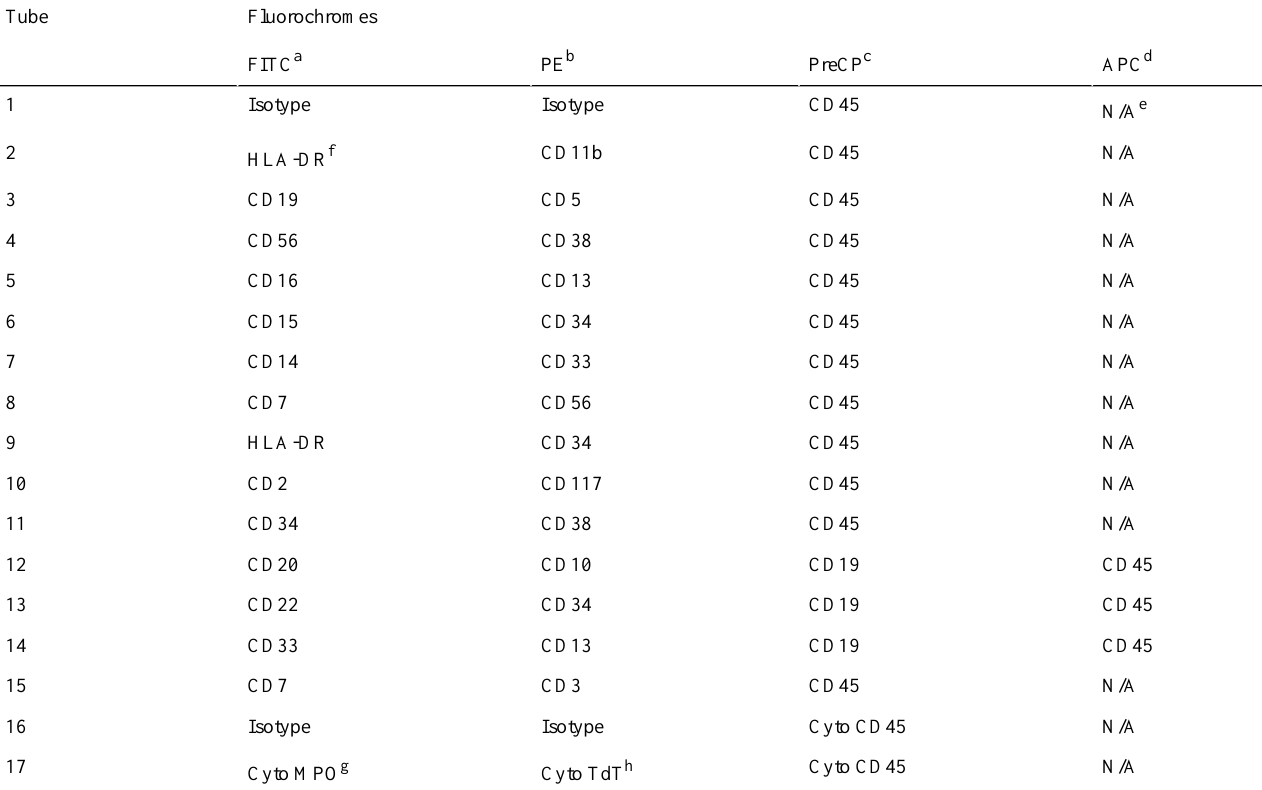
Table 2. Monoclonal antibodies: flow marker